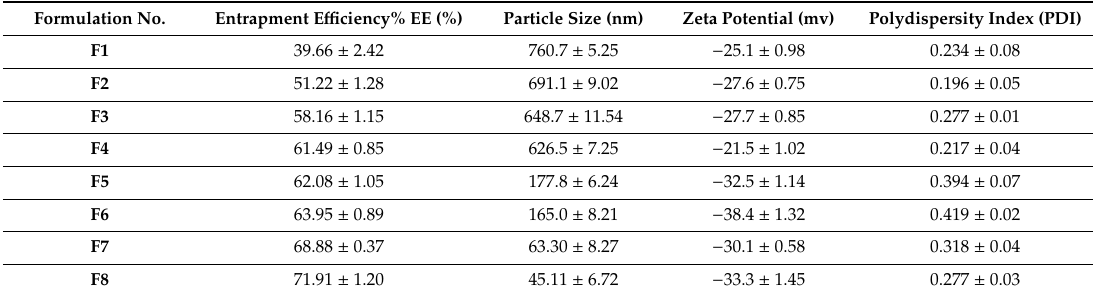
Table 2. The entrapment e ffi ciency%, particle size, zeta potential, and the polydispersity index of the prepared carbamazepine solid lipid nanoparticles